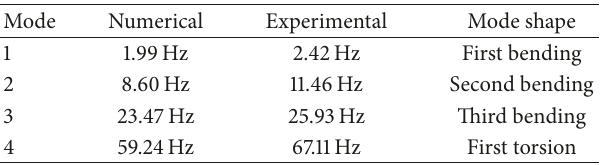
Figure 2: Configuration of the wing model for wind tunnel test. Table 1: Comparison of numerical and experimental natural fre- quency.